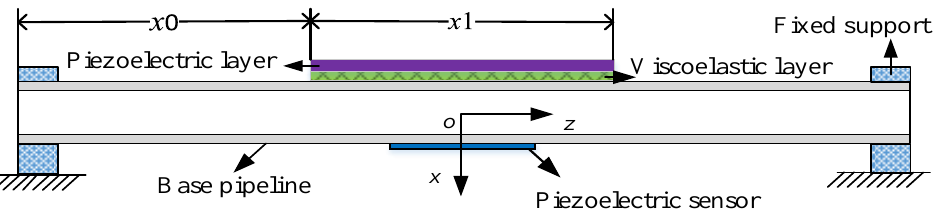
Figure 1. The fixed support model of pipeline.